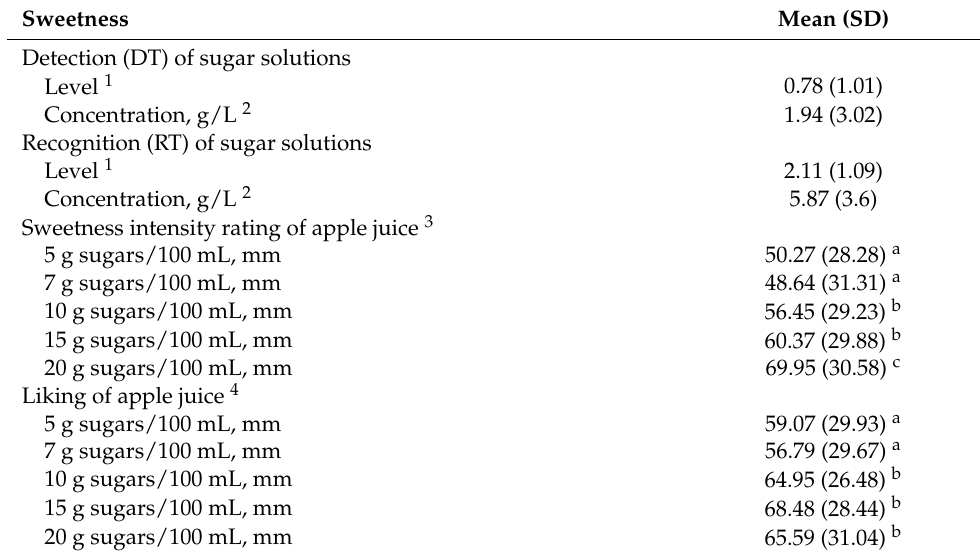
Table 3. Preadolescent’s sensitivity (DT and RT), intensity rating, and liking of